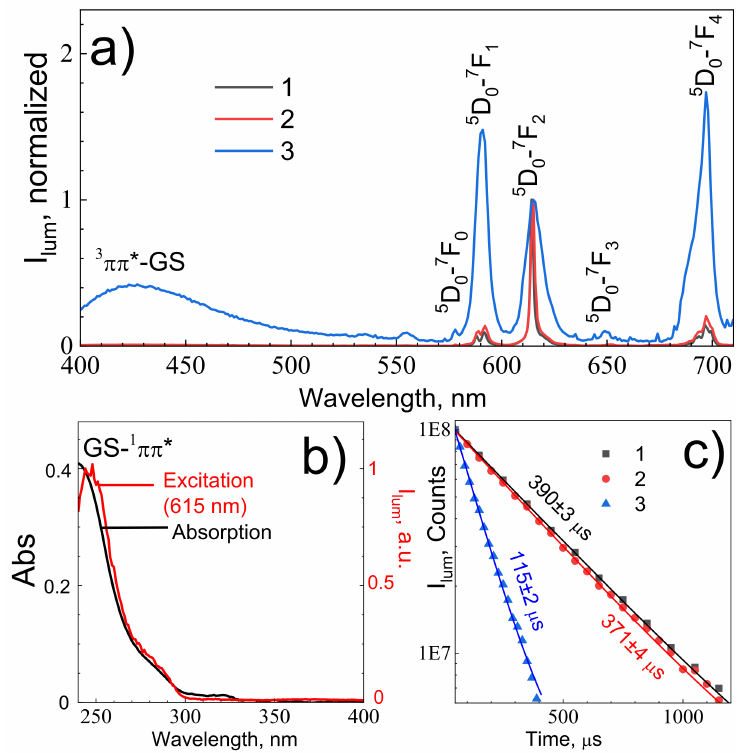
Figure 5. ( a ) The emission spectra of europium(III) terephthalate samples of different sized particles ( λ ex = 250 nm) normalized at the 615 nm emission band intensity. Sample numbers are shown in legend; ( b ) absorption (black line) and excitation (red line, λ em = 615 nm) spectra of aqueous solution europium(III) terephthalate nanoparticles 3 ; ( c ) 615 nm luminescence decay curves of europium(III) terephthalate samples of different sized